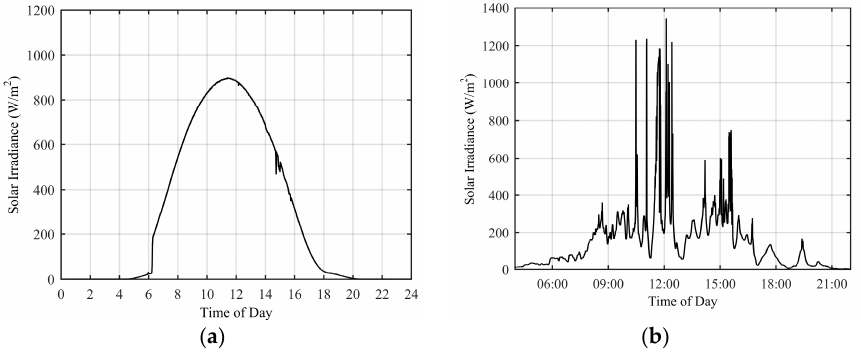
Figure 1. Irradiation variations: ( a ) during the clear-sky conditions; and ( b ) cloud-passing conditions (see Ref. [58]).